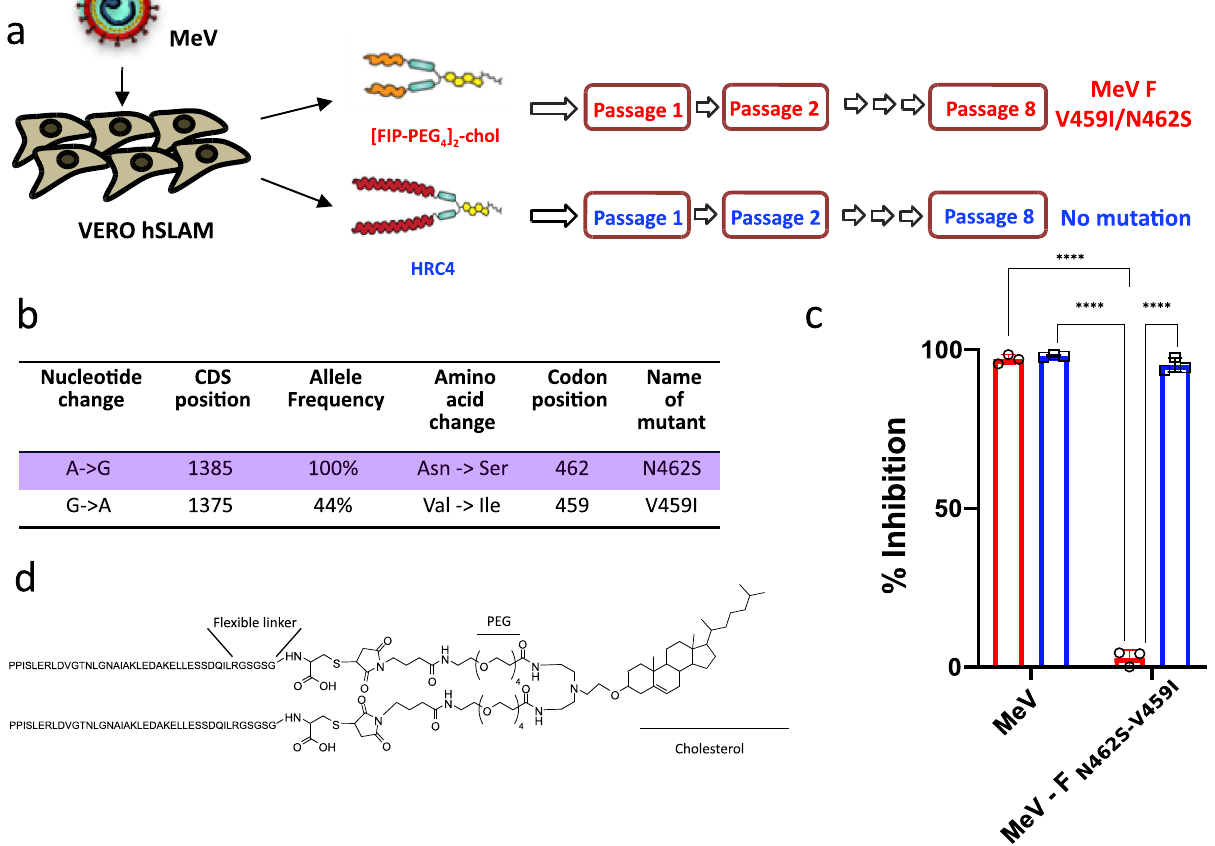
Fig. 1 | HRC4 lipopeptide treatment does not generate MeV escape variants. a Schematic presentation of viral passaging. Measles virus MeV IC323-eGFP was serially passaged 8 times on the Vero-hSLAM cells in presence of either 1 µ M [FIP- PEG 4 ] 2 -chol (red) or HRC4 peptide (blue), added to the culture after the infection. Virus wastitrated after each passage and 100 Plaque Forming Units (PFU) used for each subsequent infection. Sequencing of viral RNA after the 8 th passage revealed two mutations in the F-HRC domain for the infection done in the presence of [FIP- PEG 4 ] 2 -chol:V459IandN462S,whilenomutationsinthepresenceofHRC4peptide were found. b The mostfrequent mutation events in Fafter MeV IC323wasserially